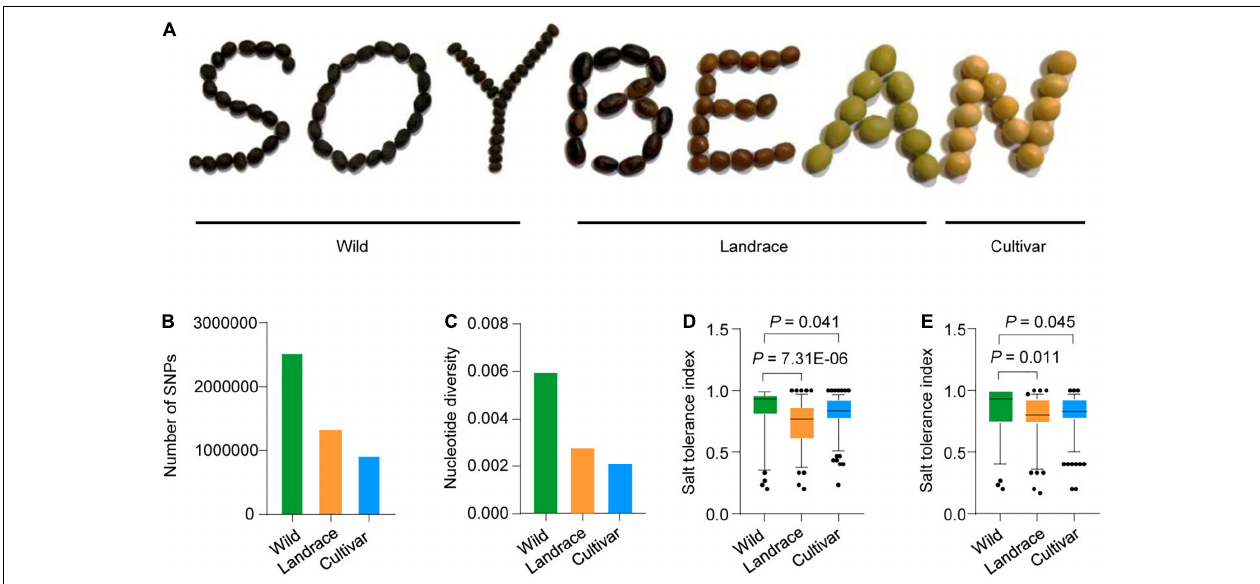
FIGURE 1 | The morphologic characteristics and salt tolerance of wild, landrace and cultivated soybean. (A) The morphologic characteristics of wild, landrace, and cultivated soybean. (B) Number of SNPs of 424 accessions in chromosome 1 genomic region. (C) Nucleotide diversity of 424 accessions in chromosome 1 genomic region. (D,E) Comparison of the salt tolerance index of 424 accessions (85 wild soybeans, 153 landraces and 186 improved cultivars); two biological replicates in greenhouse.